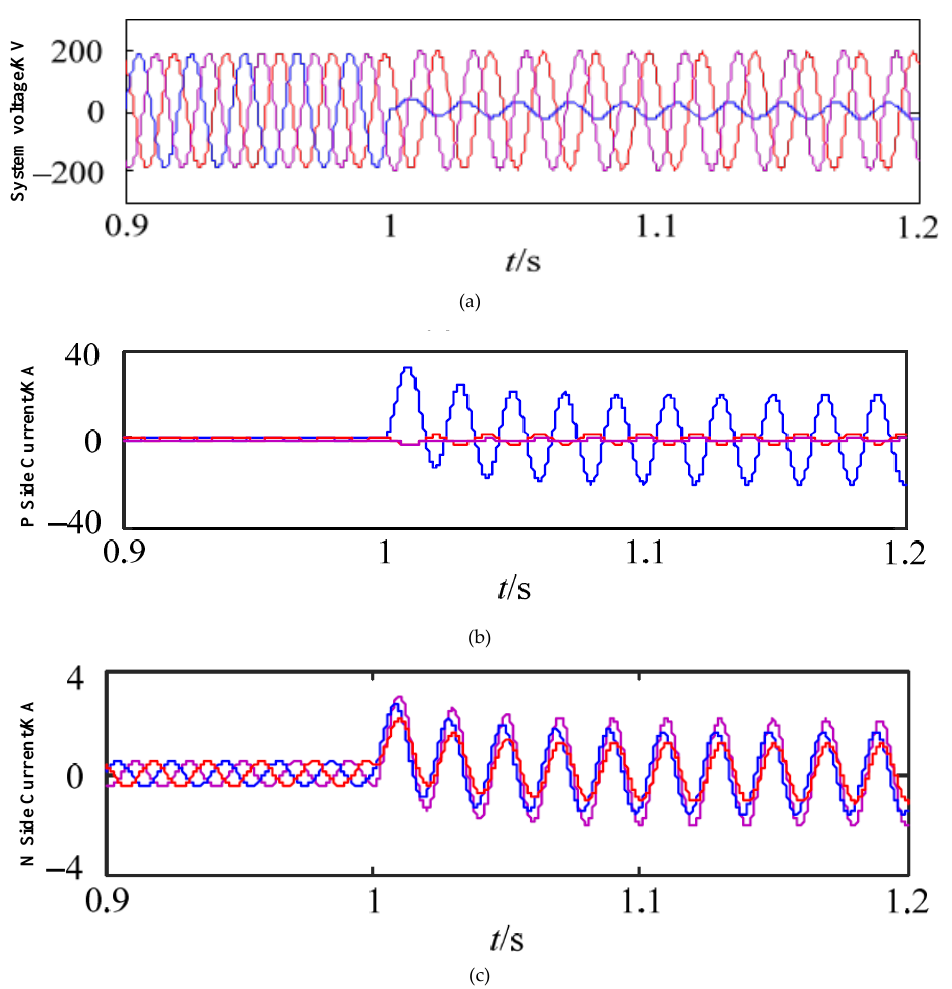
Figure 7. Phase A to ground fault waveform analysis: ( a ) system voltage, ( b ) P-side current, ( c ) N-side current.